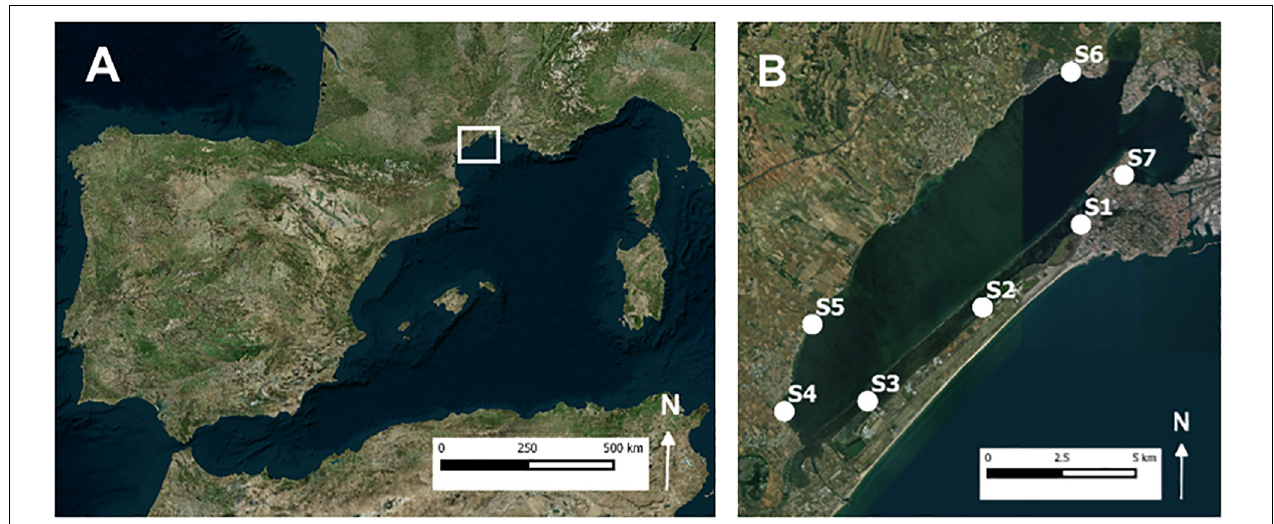
FIGURE 1 | (A) Map of West Mediterranean with study area located within square. (B) Locations of the seven sampling sites in Thau lagoon. At each sampling site 2 to 6 benthic cores were taken.